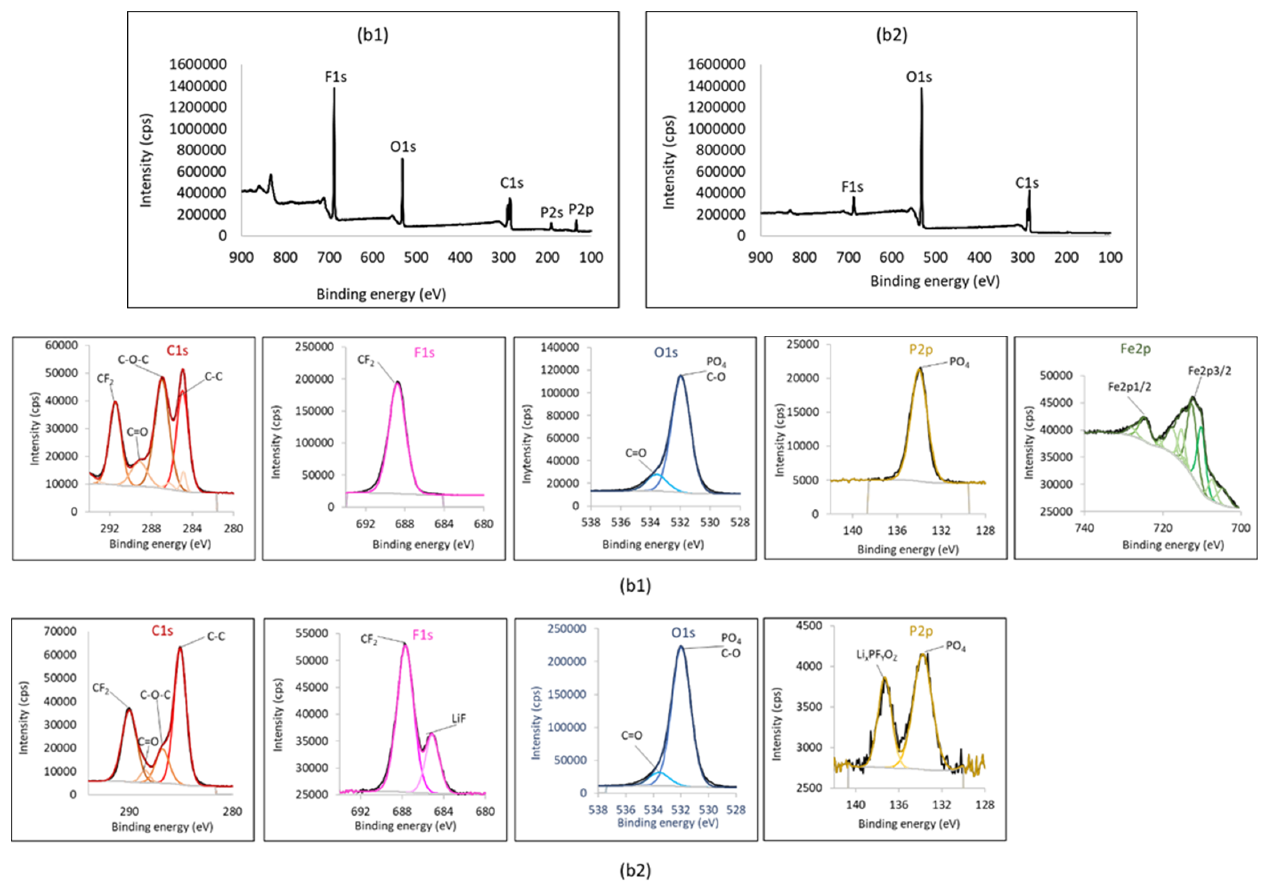
Figure 3. XPS spectra of the LFP cathode coating with PVDF binder: ( a1 ) as prepared and ( a2 ) postmortem after 25 battery cell cycles.